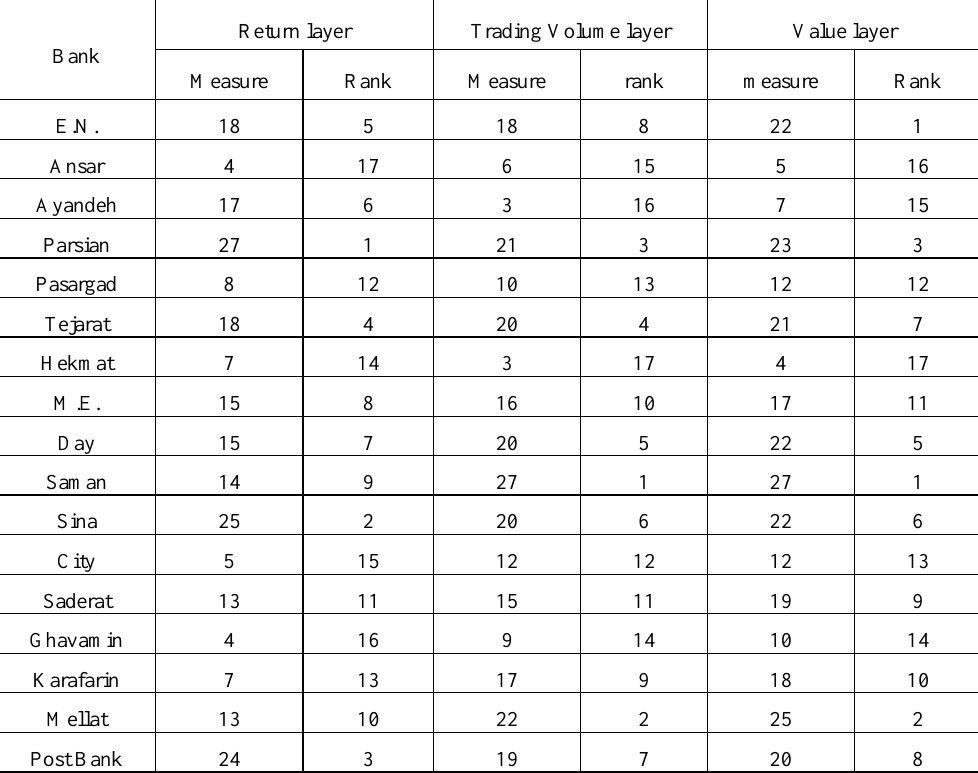
Table 3. Degree centrality in each